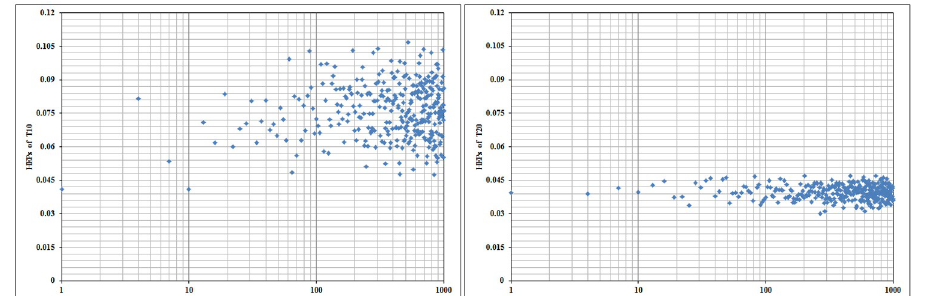
Fig 6. Results of sensitivity analysis of T10 and T20 (logarithmic scale dispersion).